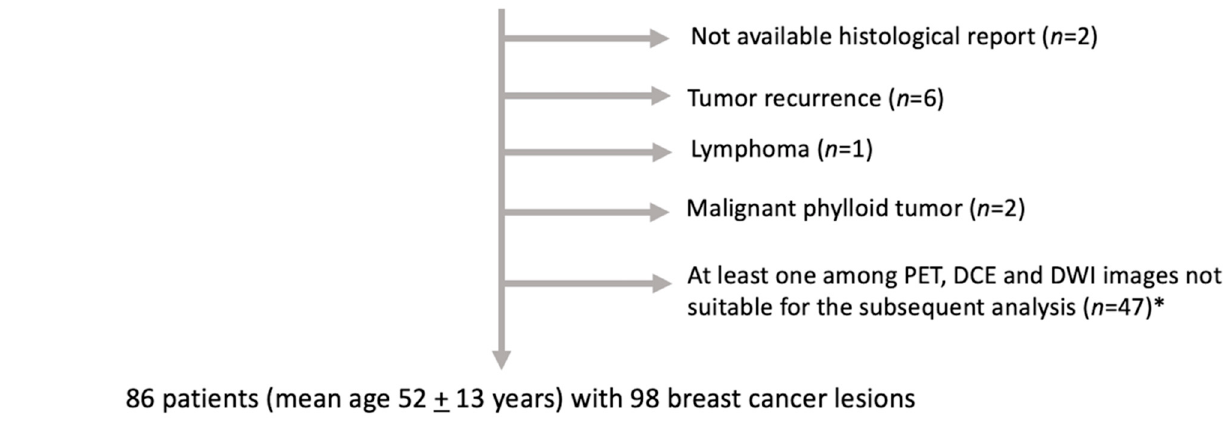
Figure 2. Flowchart of patient selection. * Low quality images, DCE images for which maps calculation was not feasible, small breast cancer lesions.